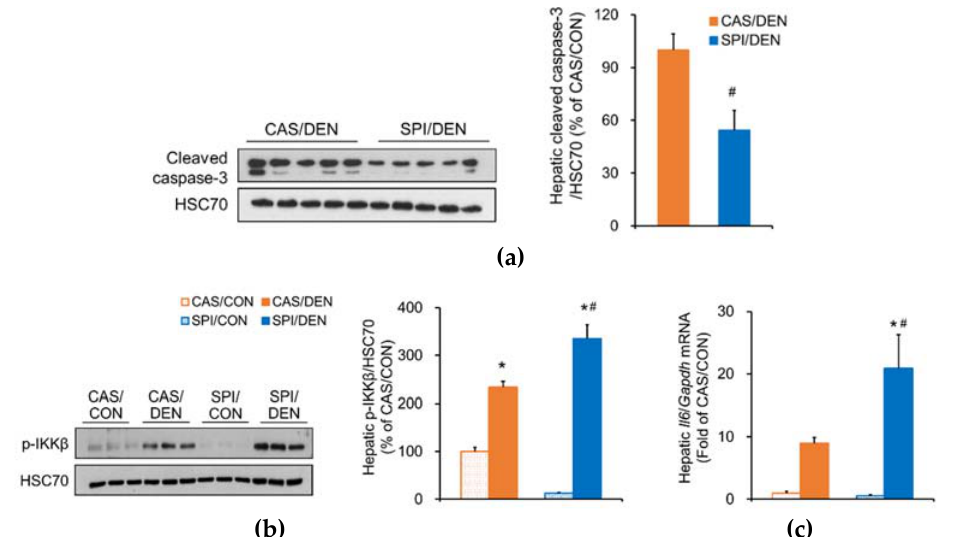
Figure 6. Effects of maternal diet on activation of anti ‐ apoptotic signaling pathway in the liver of Figure 6. E ff ects of maternal diet on activation of anti-apoptotic signaling pathway in the liver of